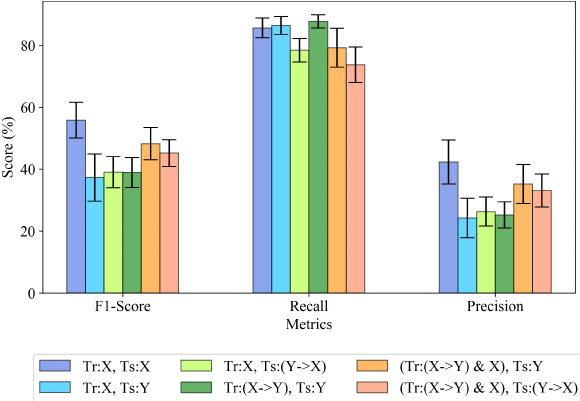
Figure 3. Temporal domain adaptation average ± standard deviation classification results in % with the identity term defined as in Equation 8.